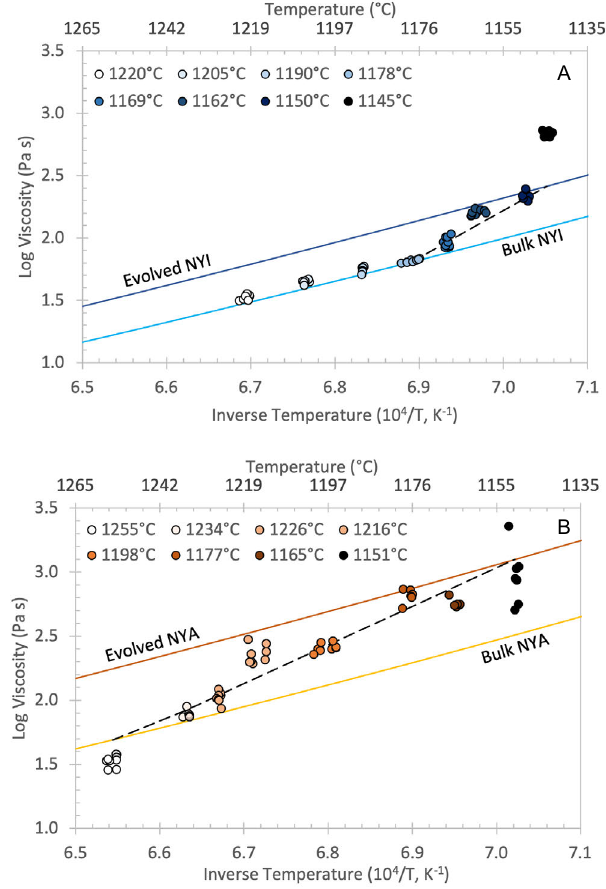
Figure 10: Viscosity modeled for the bulk remelted ma- terial (light line) and the most evolved subliquidus melt composition (dark line). Points plotted are apparent viscosities of each successive subliquidus